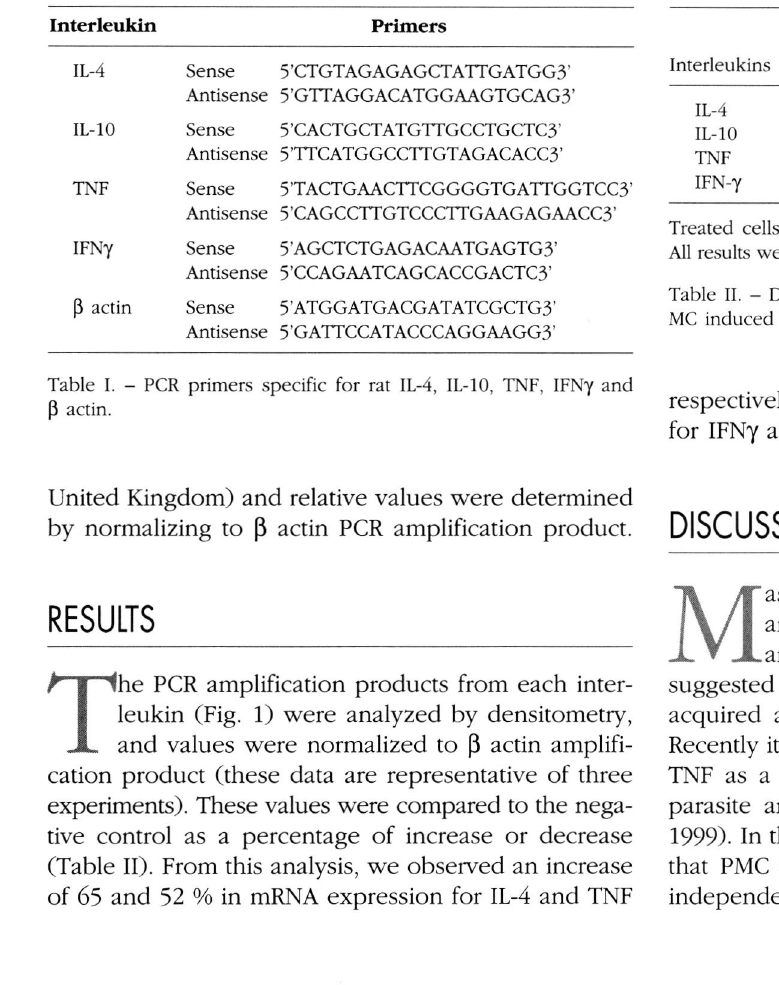
Table II. – Densitometric analysis of interleukin mRNA changes in MC induced by TSL-1